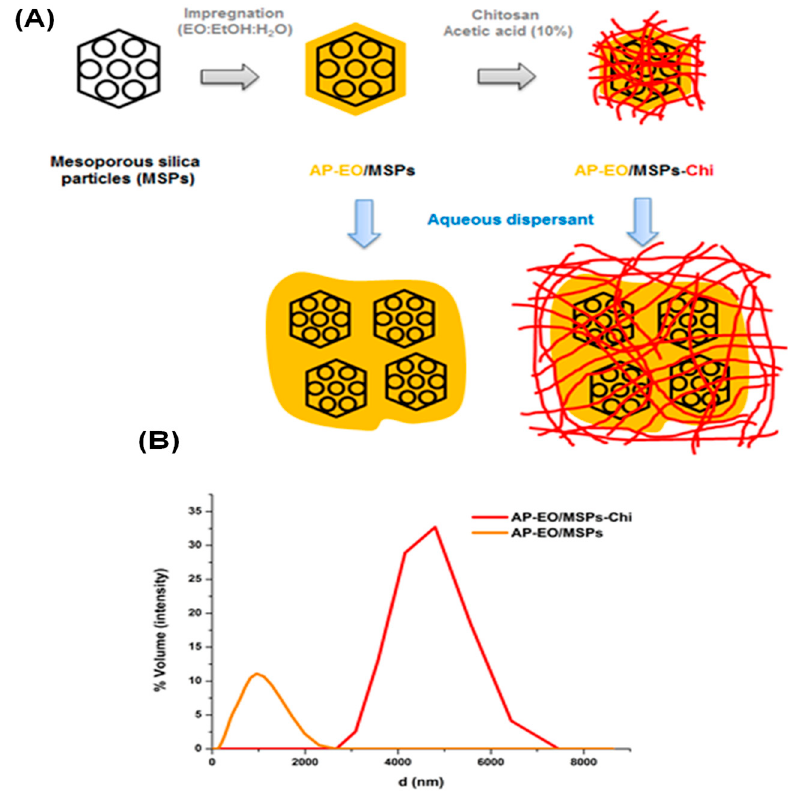
Figure 5. Encapsulation of essential oil in mesoporous silica. ( A ) Schematic illustration of the encap- sulation process, followed by a chitosan coating of the mesoporous-silica-encapsulated oil. ( B ) DLS characterization of the mesoporous-silica-encapsulated essential oil before (orange = AP-EO/MSPs), and after its coating with chitosan (red = AP-EO/MSPs-Chi).